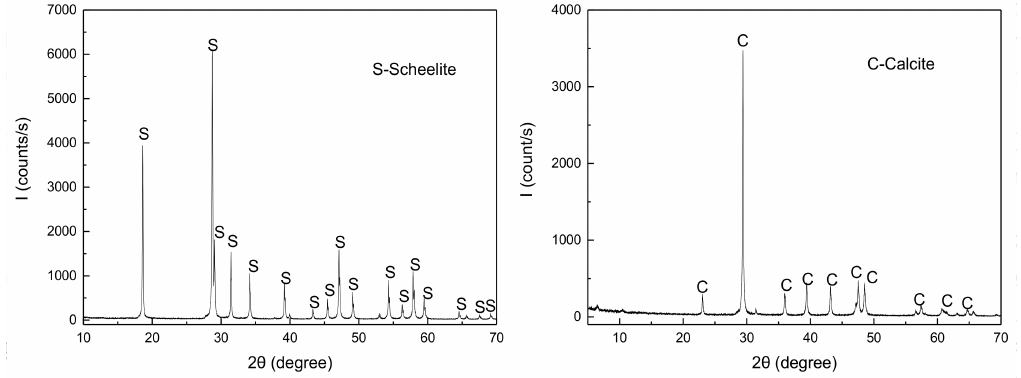
Figure 2. XRD of the two